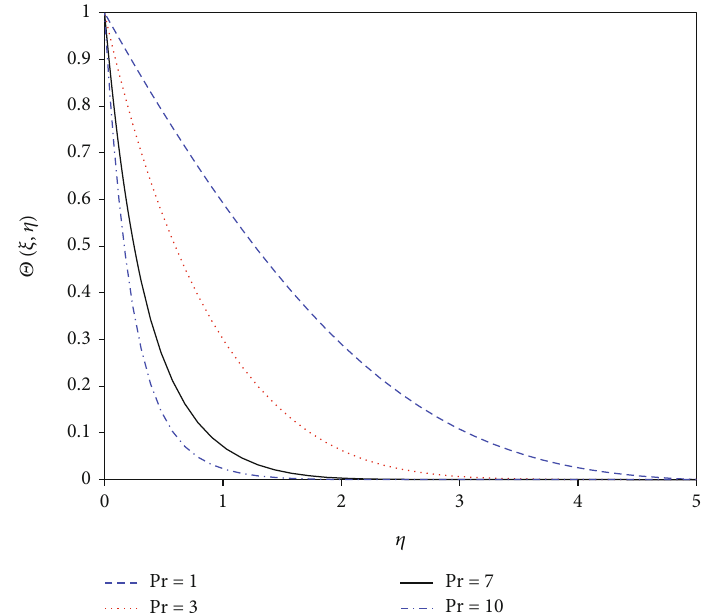
= 0 : 6, Ω = 0 : 1, and R